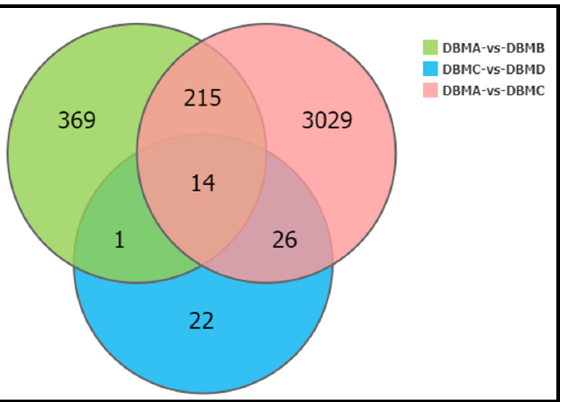
Figure 5. Venn diagram of differentially expressed genes between susceptible and resistant strains and two toxin-treated strains 24 h before sampling. DBMA represents G88-susceptible strain; DBMB represents G88-susceptible strain with toxin treatment; DBMC represents Cry1S1000-resistant strain; DBMD represents Cry1S1000-resistant strain with toxin treatment. TPM value was less than 10. Thus, after the exclusion step, 376 DEGs were left. Then, we